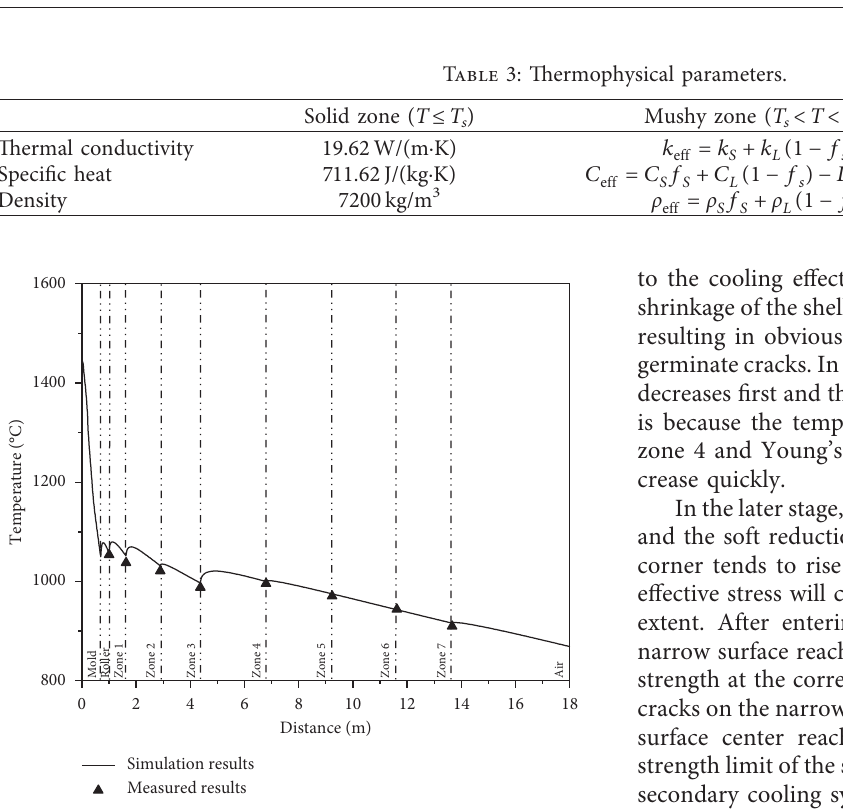
Figure 5: Comparison between the simulation results and results measured by the inbuilt model of the casting machine at the exit of each